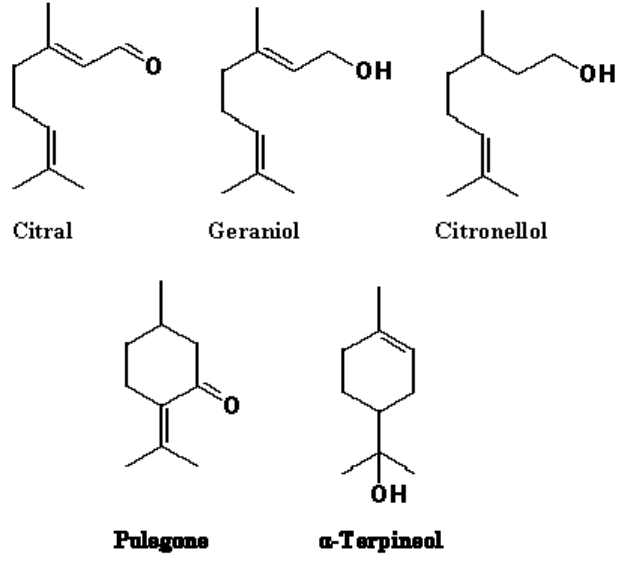
Figure 2. Chemical structures of monoterpenes with pronounced effect on swarming